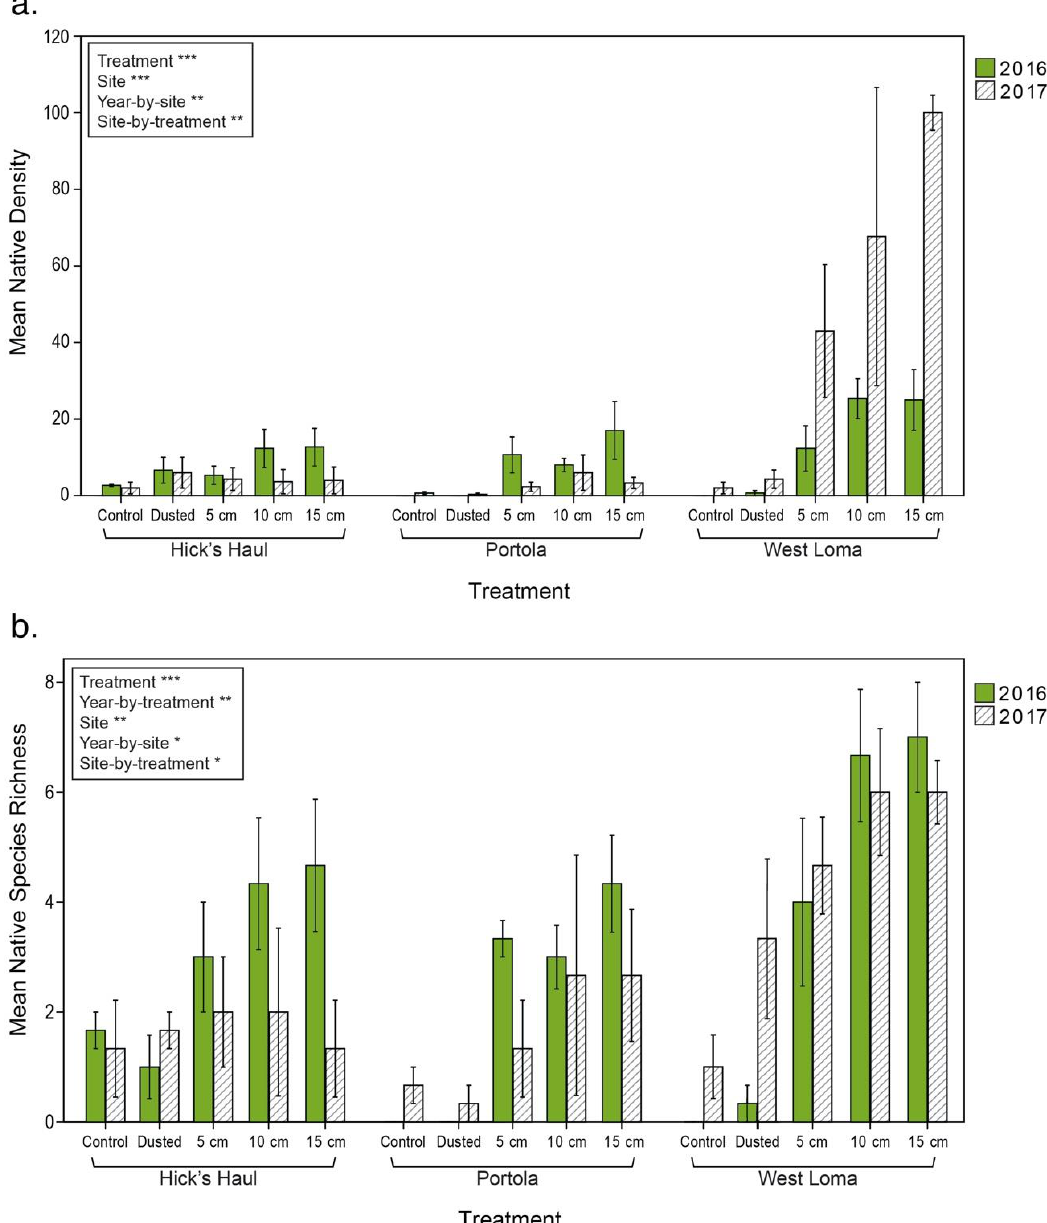
Figure 5. Mean native density ( a ) and mean native species richness ( b ) by treatment at the donor sites. Bars represent +/- 1SE of the mean (repeated measured ANOVA *** p < 0.0001, ** p < 0.01, * p < 0.05).